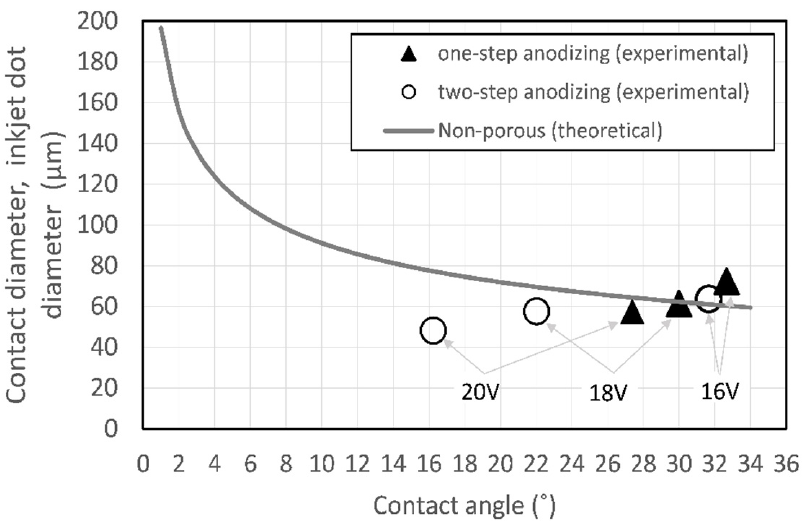
Figure 9. Theoretical droplet contact diameter according to contact angle on a non-porous surface and experimental inkjet dot diameters according to the water contact angles on different AAO films.